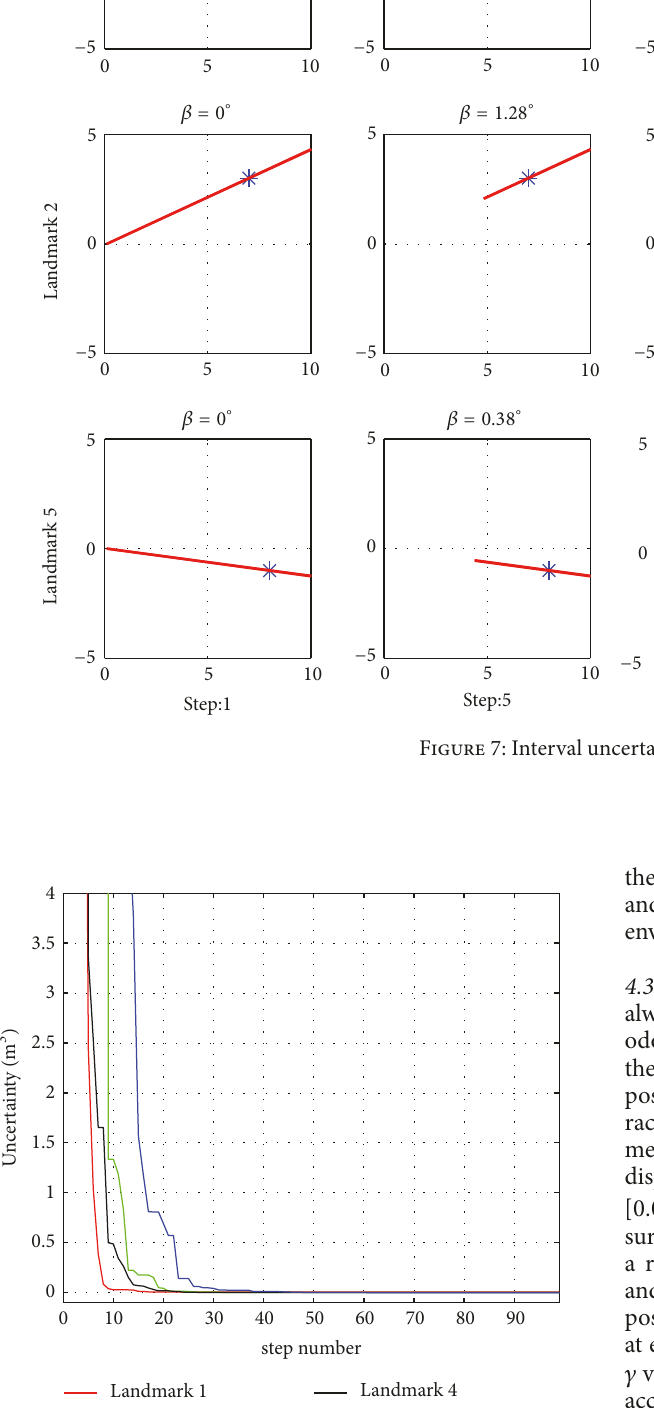
Figure 8: Landmark position uncertainty